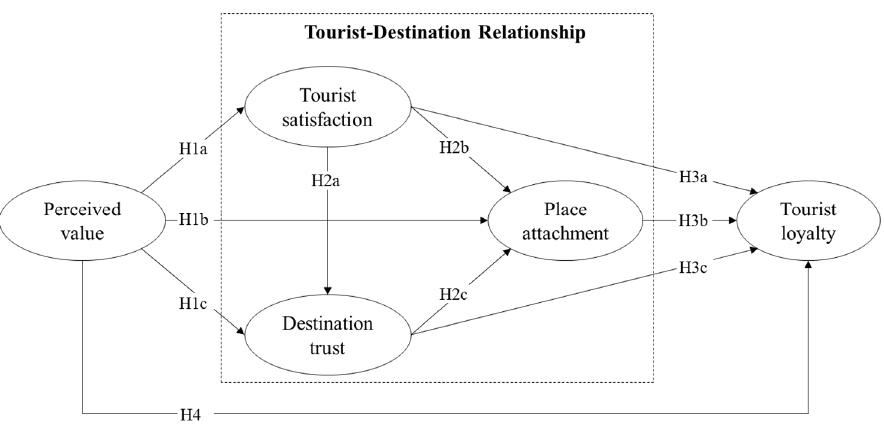
Figure 1. Conceptual model and hypotheses.